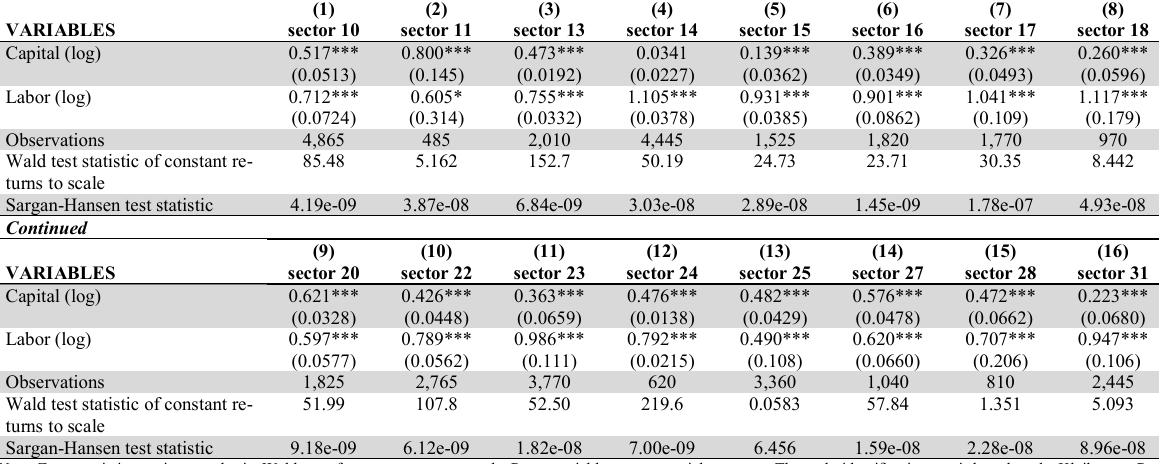
Cobb-Douglas production function estimation using Ackerberg-Caves-Frazer estimator (Dependent variable: Value added (logarithm),